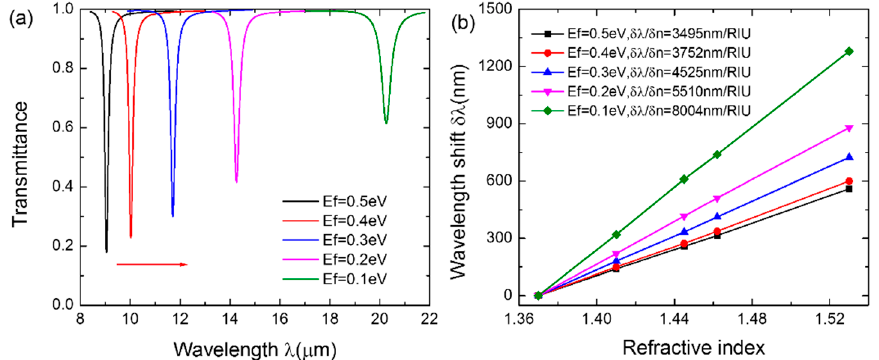
Figure 4. ( a ) The transmission spectra with varying E f when Λ = 200 nm, H = 100 nm, and W = 40 nm. ( b ) The calculated sensitivity when E f = 0.5 eV, 0.4 eV, 0.3 eV, 0.2 eV, and 0.1 eV, respectively. The lines are linear fittings to the data.